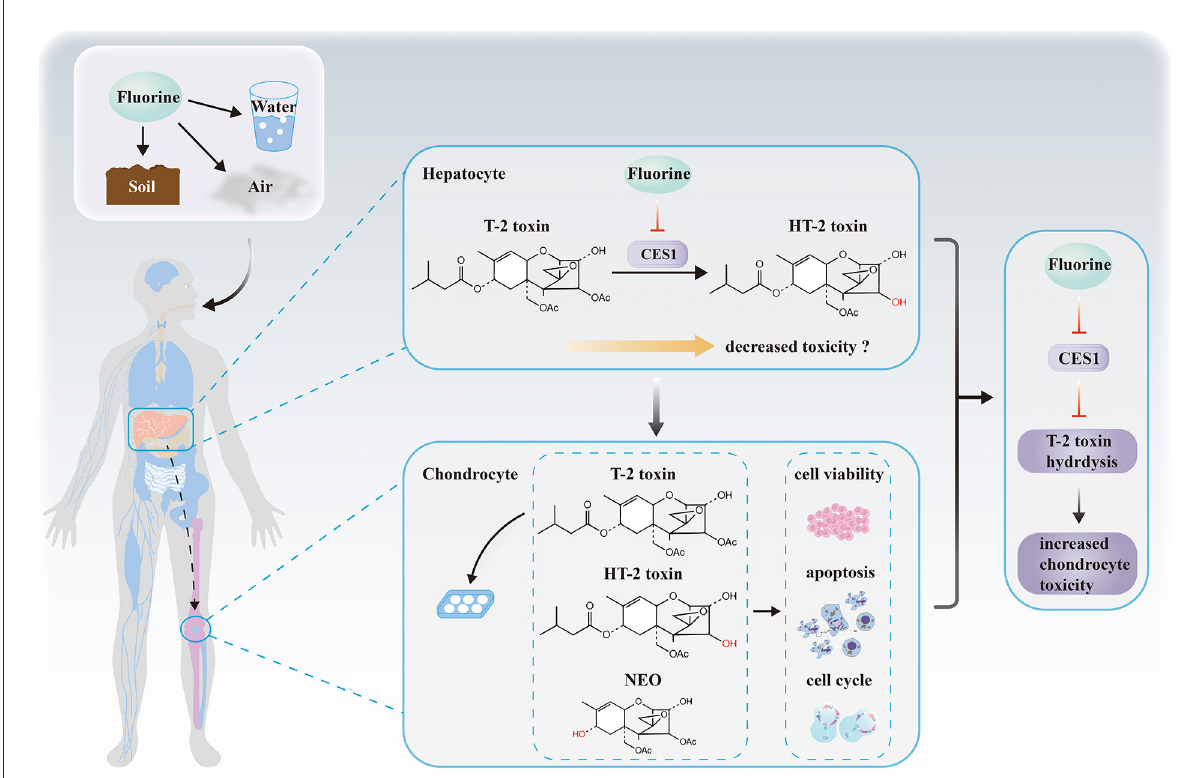
FIGURE7 Proposed hypothetical mechanisms revealing the relationship among fluorine, hepatic CES1, T-2 toxin hydrolysis, and chondrocyte toxicity. No causality has been established between the hepatic drug-metabolizing enzymes and chondrocyte toxicity. We suppose that fluorine in the external environment affects the expression and activity levels of CES1 in hepatocytes. Then, we demonstrate CES1 is responsible for the hydrolysis and detoxification of T-2 toxin. Finally, fluoride indirectly decreases the hydrolytic metabolism of T-2 toxin via CES1 and subsequently increases T-2 toxin-induced chondrocyte